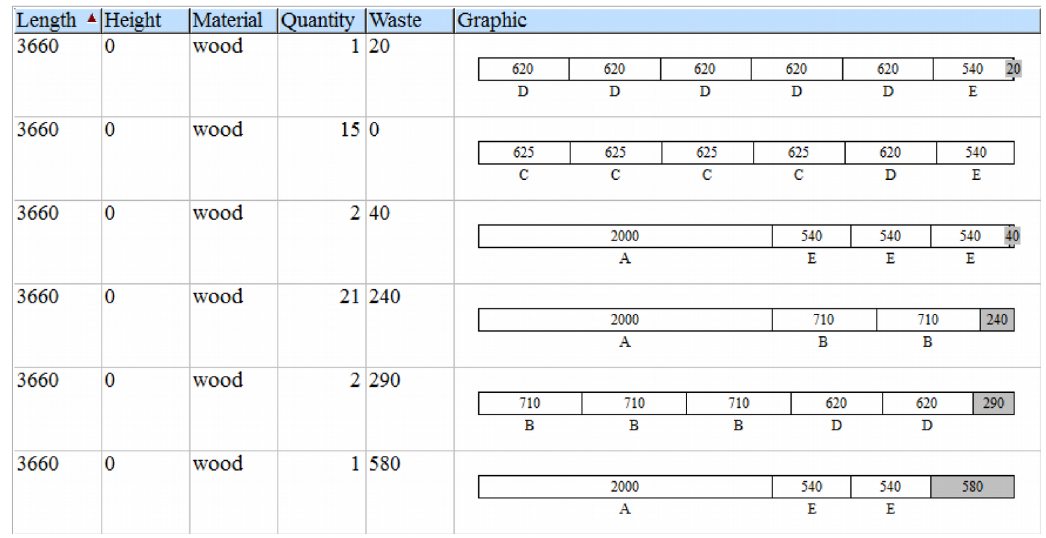
Figure 5. Optimal Cutting Plans generated using package